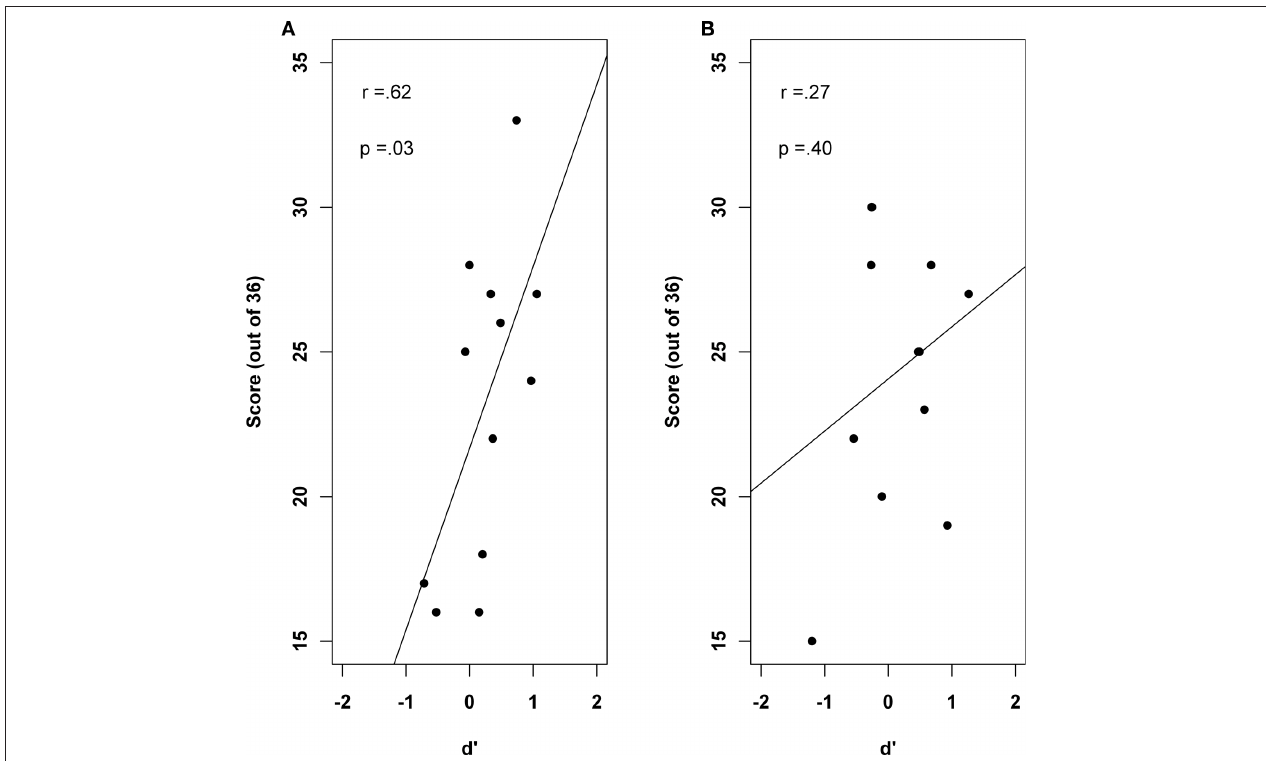
FiGuRe 4 | scatter plot showing the significant correlation between d ′ and performance for the control group (A) and the null correlation in the amusic group